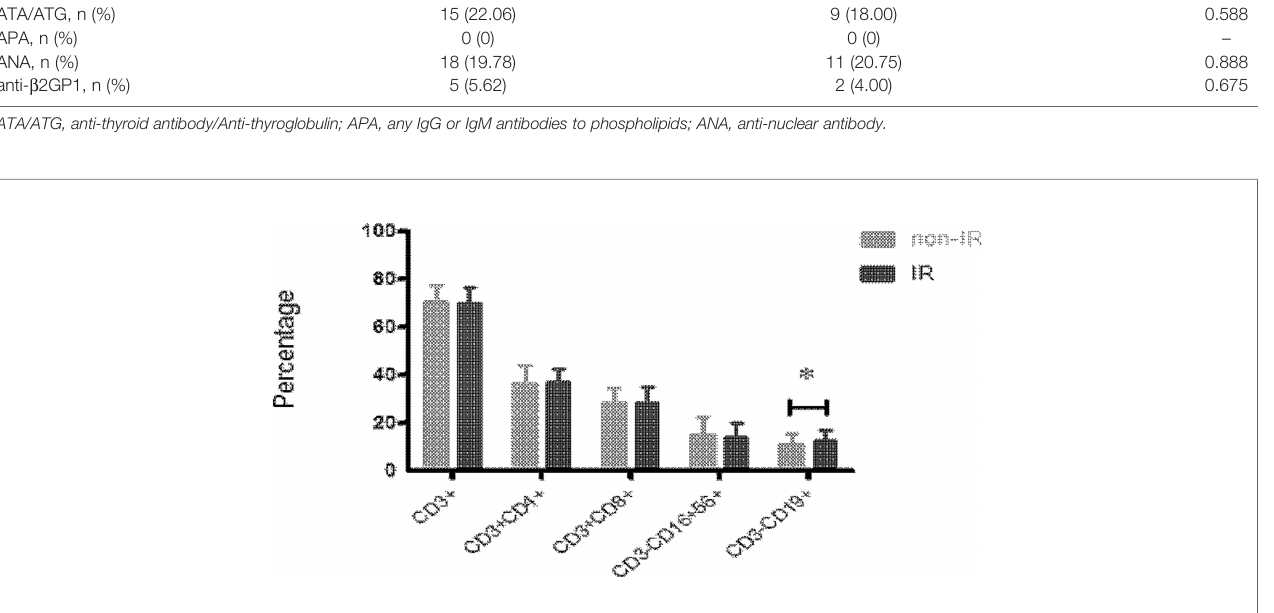
FIGURE 2 | The peripheral blood immunophenotypes of immune effectors, including CD3+, CD3+CD4+, CD3+CD8+, CD3+CD16+CD56+ and CD3+CD19+ cells, were analyzed in the samples of 58 women with IR and 97 women without IR in lean women (16<BMI<25). The proportion of peripheral blood CD19 + B cells was signi fi cantly higher in lean patients with IR as compared with those without IR. Data are represented as the mean ± SD. Signi fi cance was determined using the two-tailed Student t-test. * P <